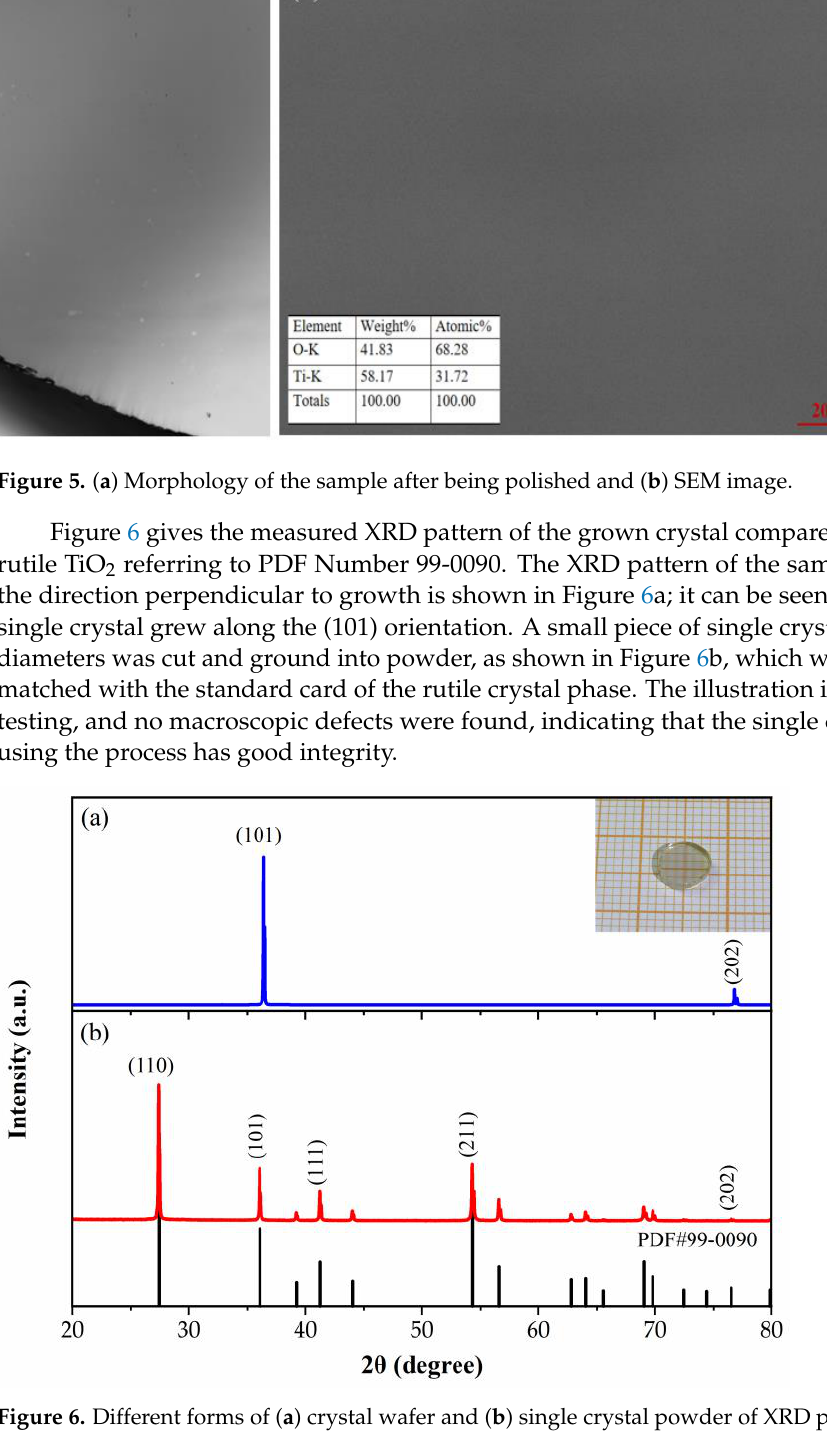
Figure 6. Different forms of ( a ) crystal wafer and ( b ) single crystal powder of XRD patterns.